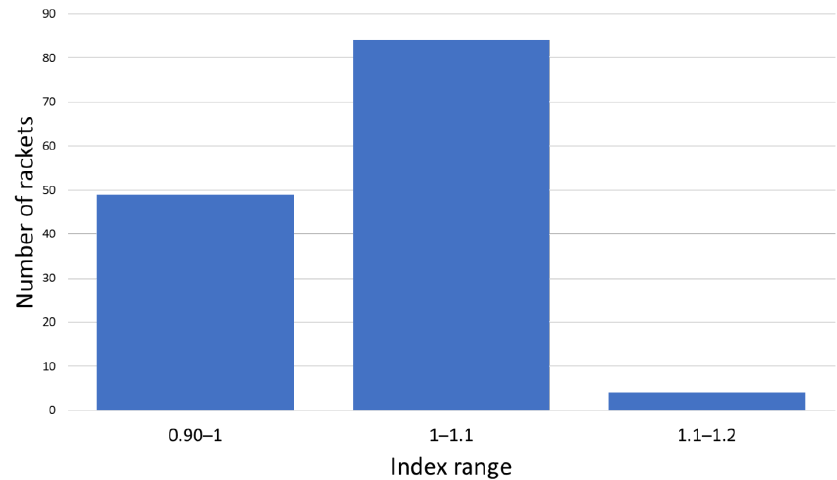
Figure 17. Results for the maneuverability parameter for the 137 padel rackets studied.